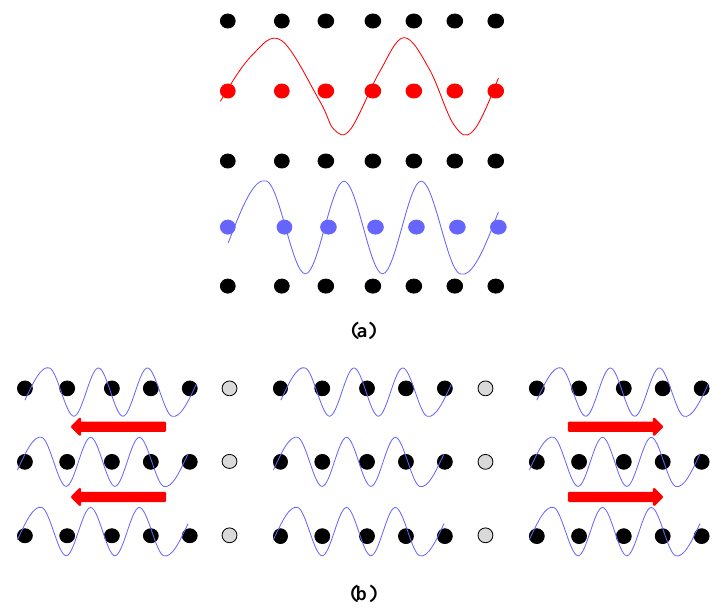
Figure 5. Proposed magnonic crystal structures by magnetic ion doping ( a ) and non-magnetic ion doping ( b ) for controlling spin wave.